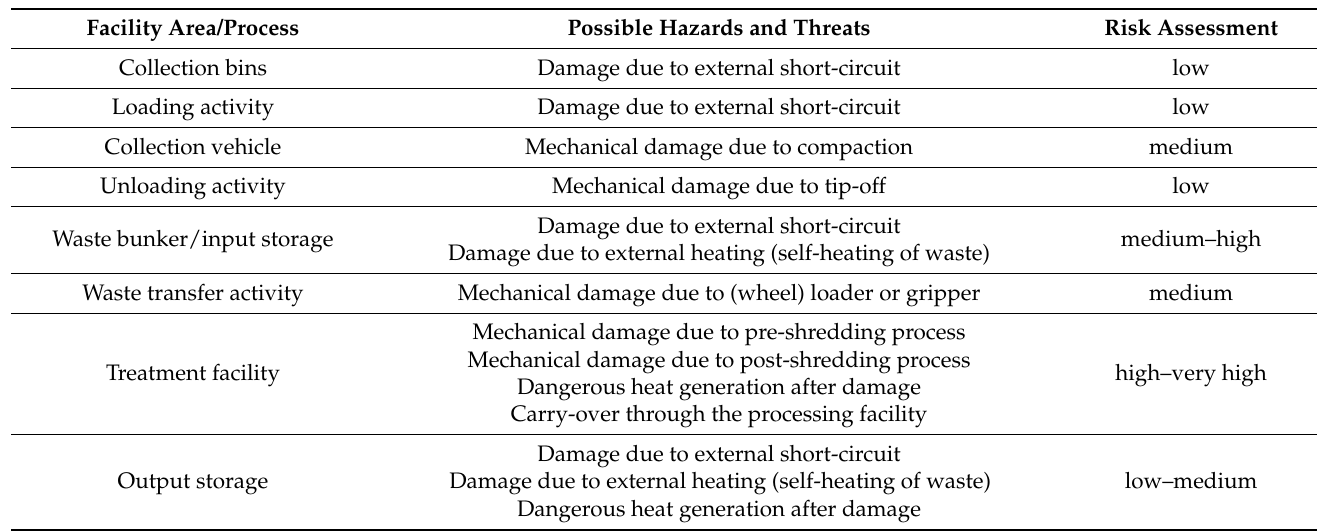
Table 5. Qualitative risk assessment of possible hazards and threats of portable batteries (waste stream: residual household waste). Facility Area/Process